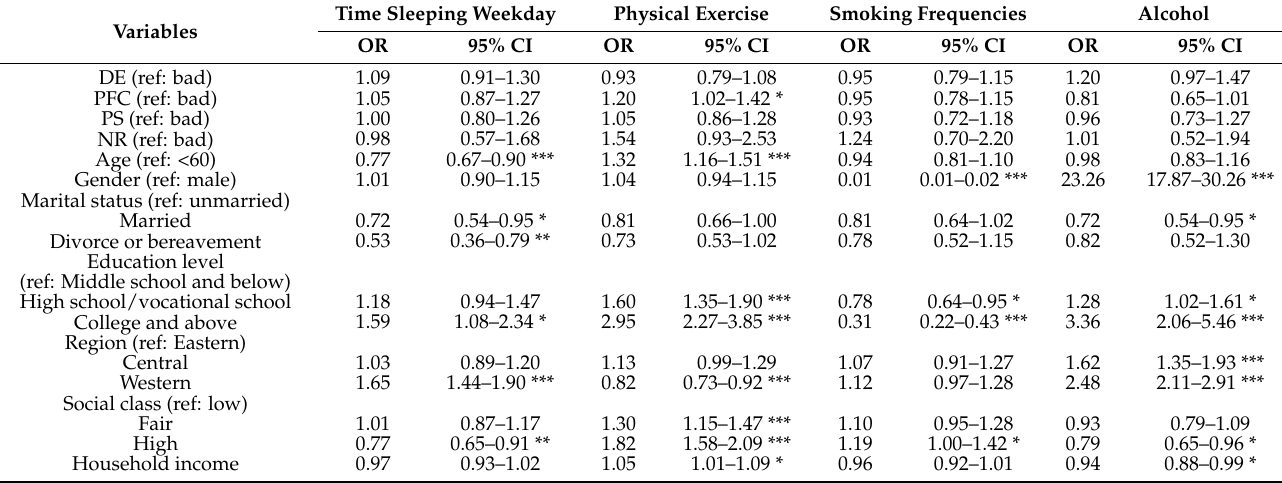
Table 3. The associations between of self-perceived neighborhood environment and with health-related behaviors.